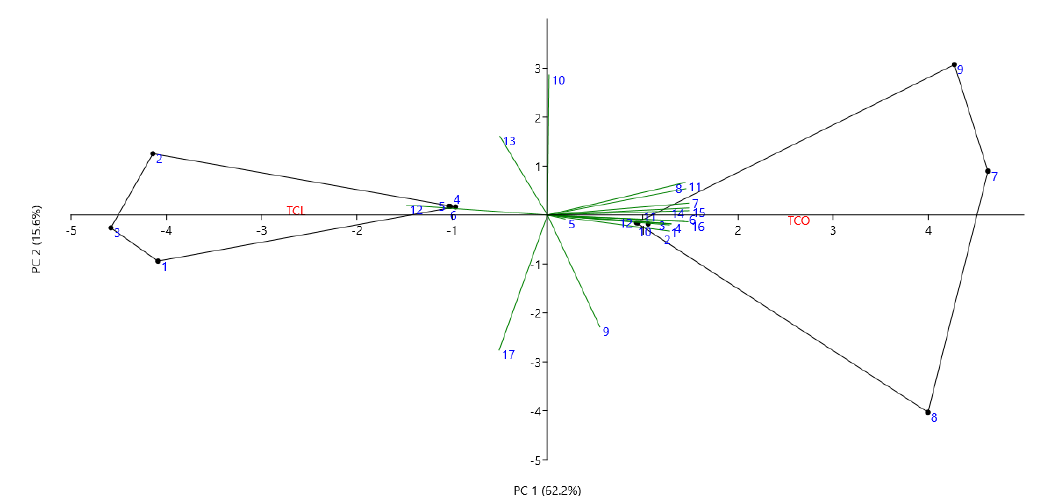
Figure 4. Principal component analysis (PCA)-biplot of Tea Compagnia del Lago (TCL) and Tea Camelia d’Oro (TCO), by means of the PAST 4.03 software. 1. Polyphenols; 2. FRAP; 3. DPPH; 4. ABTS; 5. caffeic acid; 6. chlorogenic acid; 7. coumaric acid; 8. ferulic acid; 9. hyperoside; 10. isoquercitrin; 11. quercetin; 12. quercitrin; 13. rutin; 14. ellagic acid; 15. gallic acid; 16. catechin; 17. epicatechin.